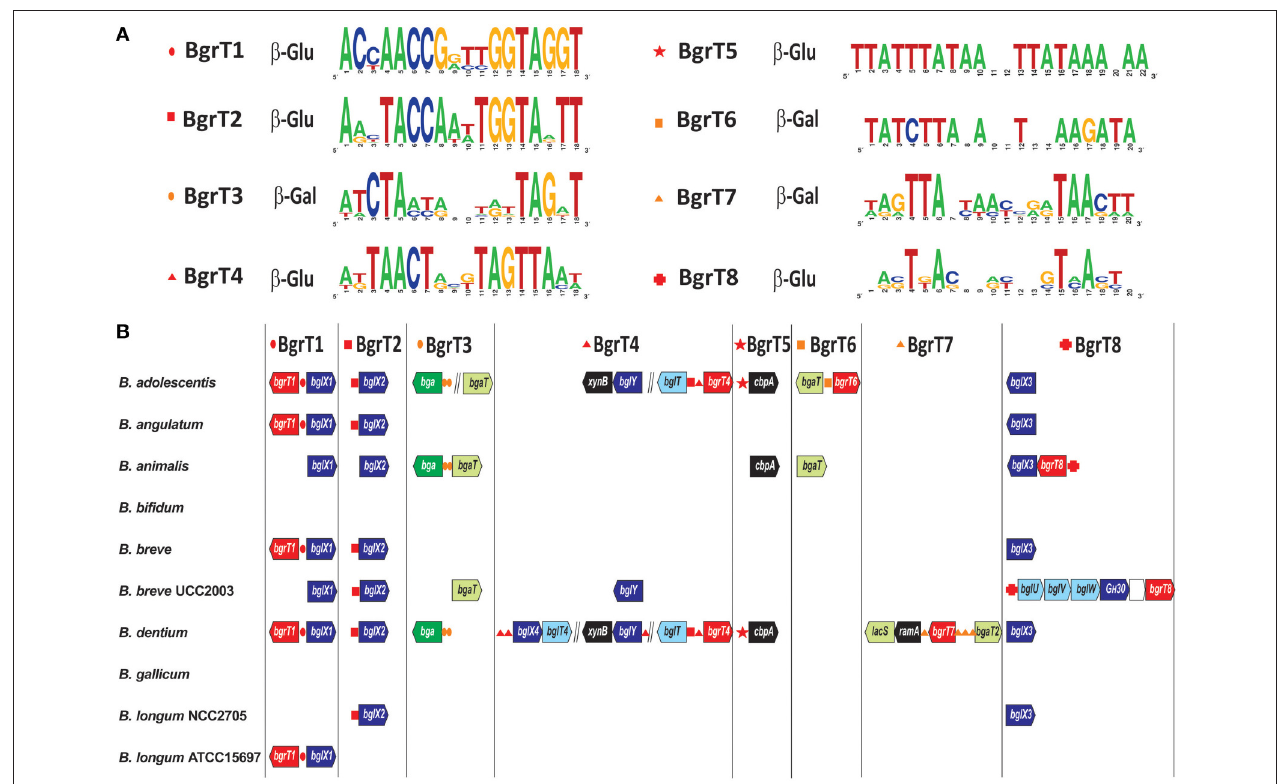
FIGURE 3 | Genomic organization of TetR-family regulons for β -glucoside and β -galactoside utilization genes in bifidobacteria. (A) Consensus sequence logos for predicted DNA binding sites of eight orthologous groups of BgrT regulators. The predicted carbohydrate specificity of regulators toward β -glucoside ( β -Glu) or β -galactoside ( β -Gal) is indicated. (B) Genomic context of BgrT regulons in 10 Bifidobacterium genomes. Genes from each regulon are shown by arrows. Candidate regulator binding sites are shown by small red and orange symbols before their respective target genes. Genes encoding predicted β -glucoside and β -galactoside transporters are in light-blue and light-green, respectively. β -glucosidases and β -galactosidases are in dark blue and green, respectively. Other glycosyl hydrolases and phosphorylases are in black. BgrT regulators are in red. Vertical lines separate operons that are not adjacent on the